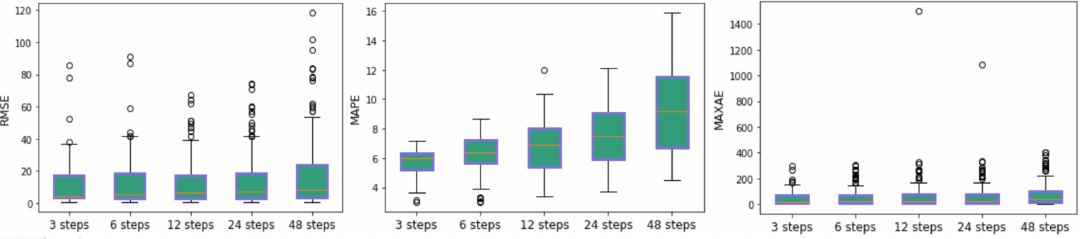
Figure 16. The distribution of RMSE, MAPE and MAXAE for ARIMA forecasting method in the five multi-step forecasting